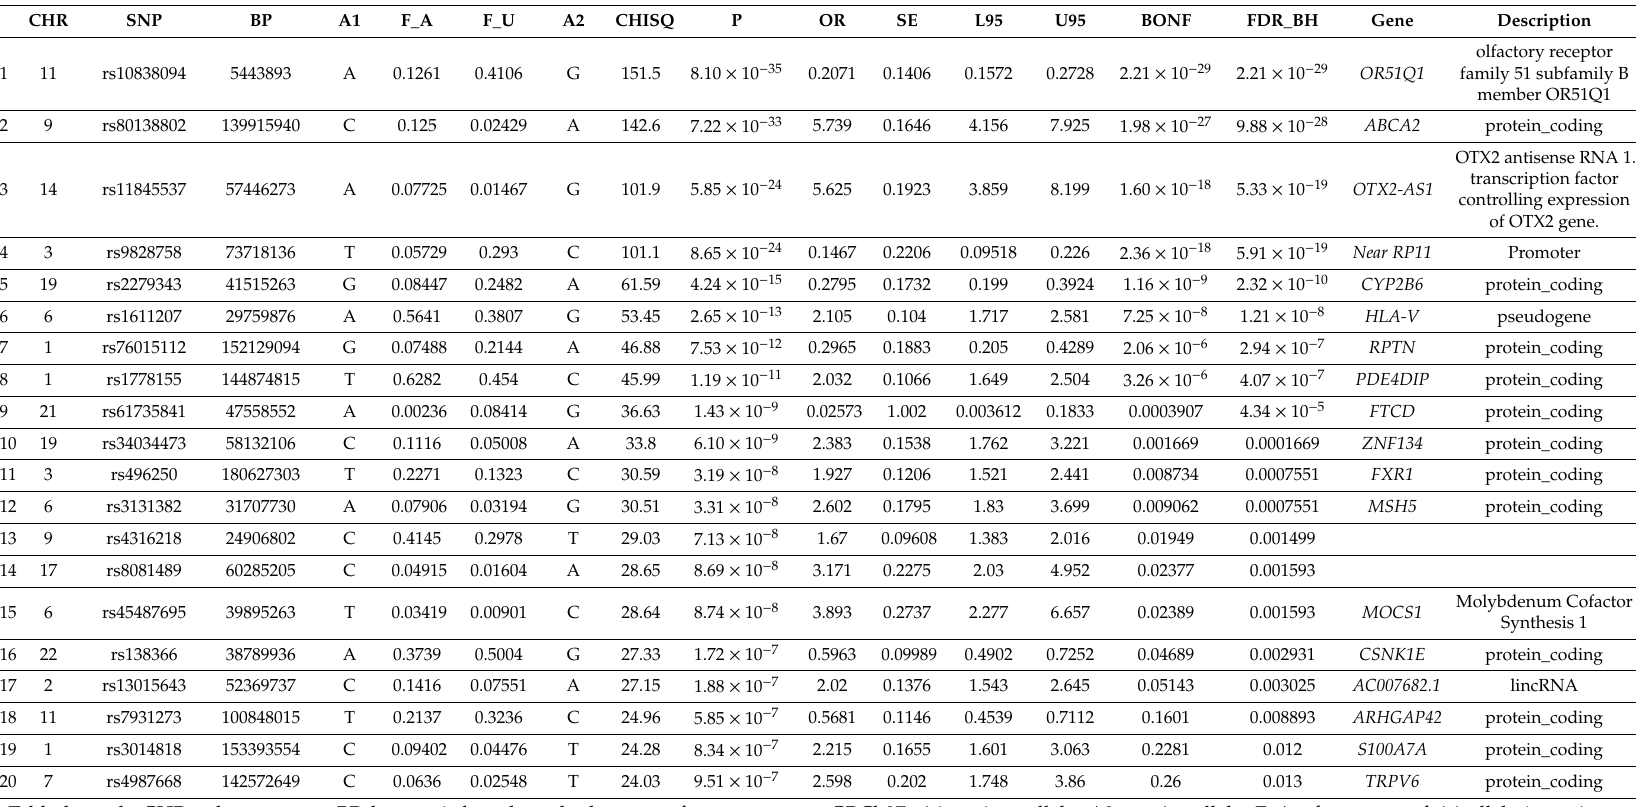
Table legend: CHR—chromosome, BP–base pair based on the human reference genome GRCh37, A1—minor allele, A2—major allele, F_A—frequency of A1 allele in patients, F_U—frequency of A1 allele in controls, CHISQ—basic allelic test chi-square (1df), P— p -value for CHISQ, OR—odds ratio, SE—standard error, L95 and U95—95% confidence interval for odds ratio, lower bound and upper bound, respectively, BONF—Bonferroni single-step adjusted p -values, FDR_BH—Benjamini & Hochberg (1995) step-up false discovery rate